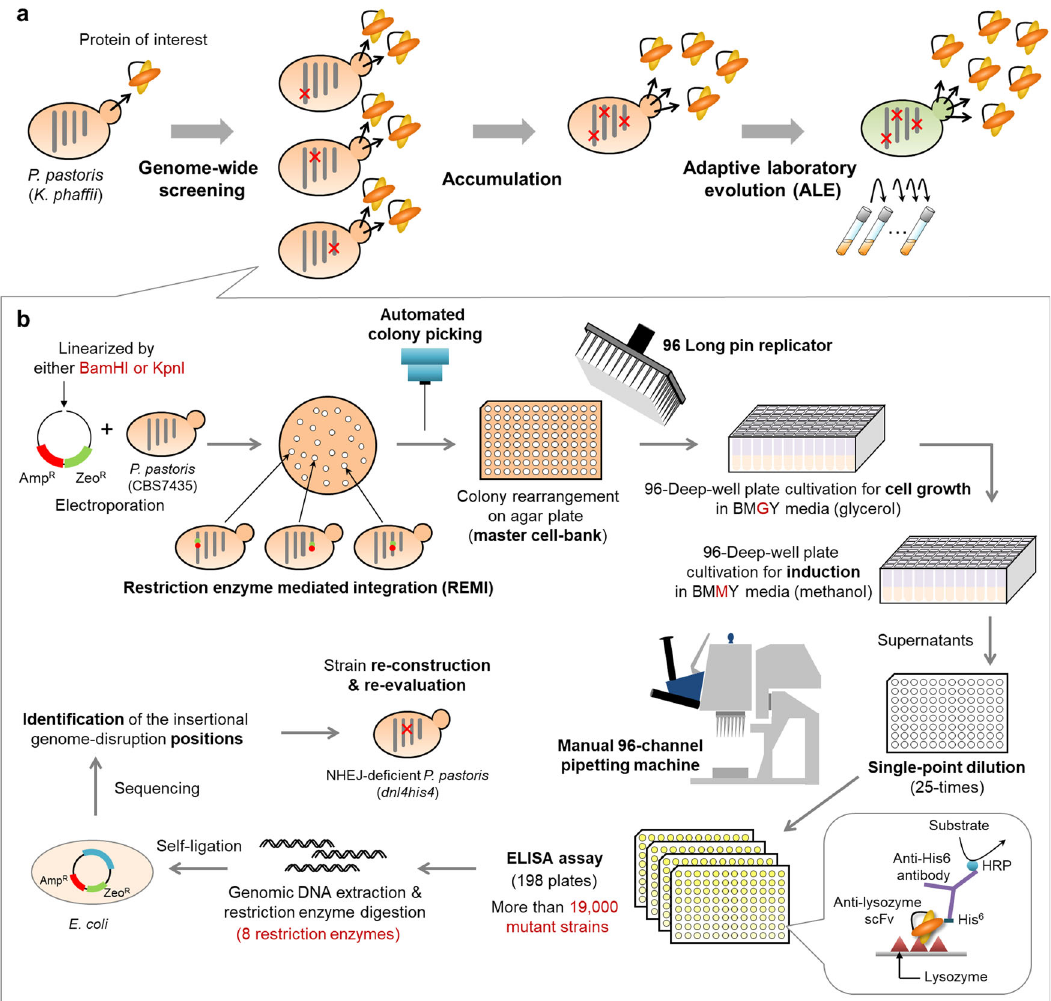
Fig. 1 Strain development strategy for enhanced recombinant secretory protein production by K. phaf fi i . a Outline of our strain development scheme. Genome-wide high-throughput screening (HTS) for gene-disruption-type effective factors, and combining perturbations, can improve secretion of a